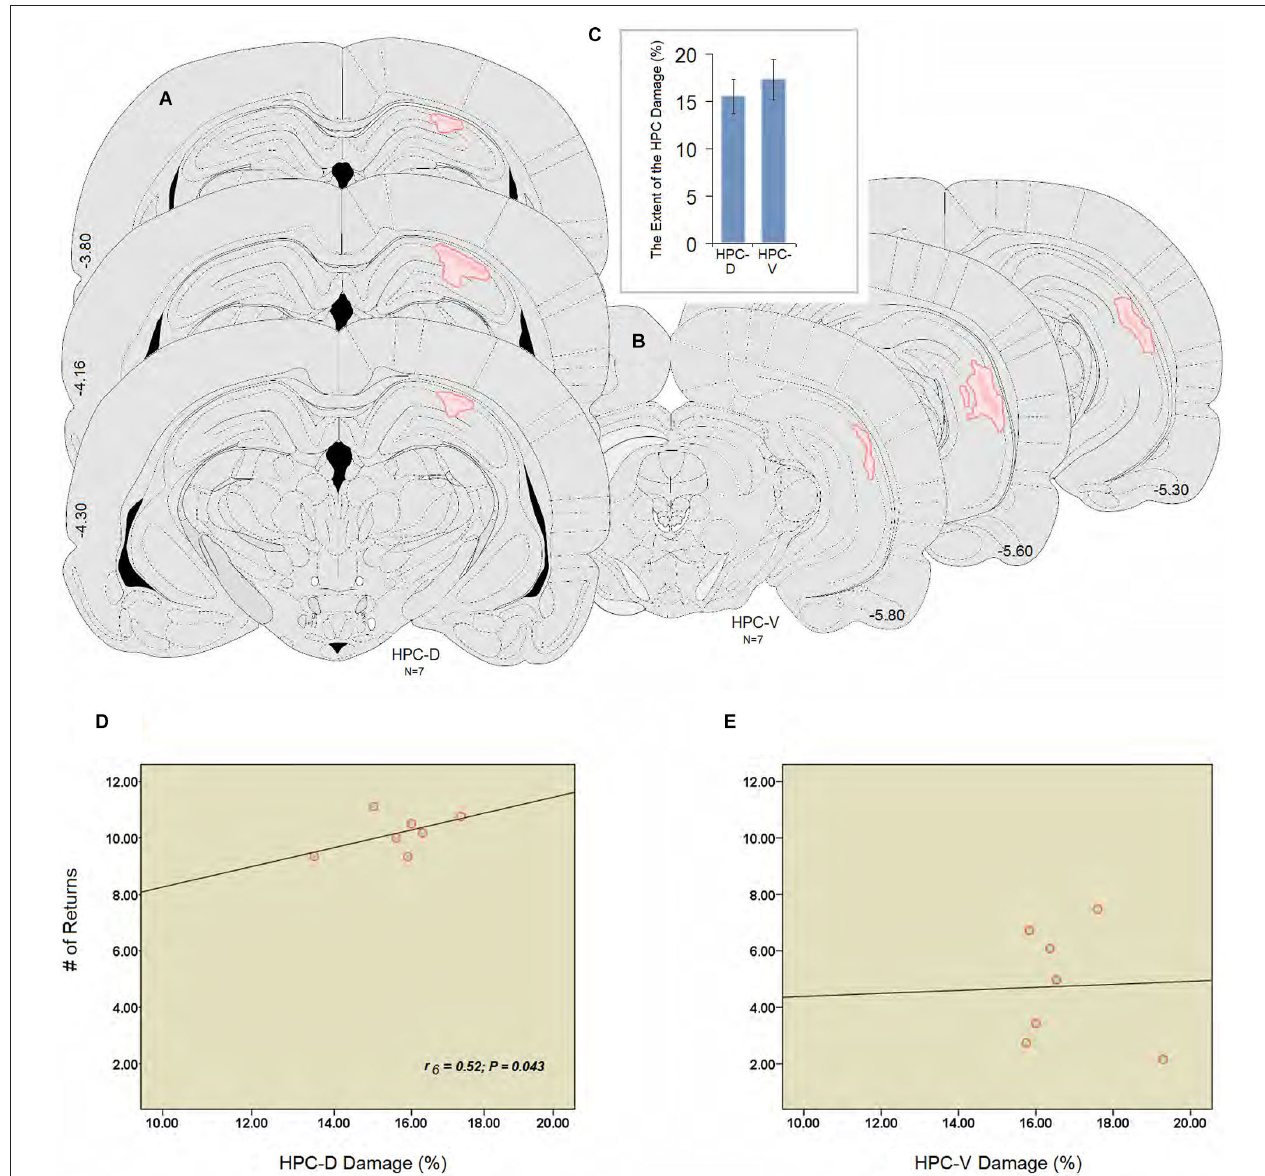
equally affected by the ET-1 infusion into the hippocampus. ( D and E ) Correlation between the percent damage induced by ET-1 in the dorsal (D) and the ventral (E) hippocampus, and the number of returns during spatial investigation in the ZT. The number of returns was significantly correlated to the damage percent only in the dHPC rats. Error bars show ± SEM. Atlas plates are from Paxinos and Watson (1997). HPC-D: dorsal hippocampus; HPC-V: ventral